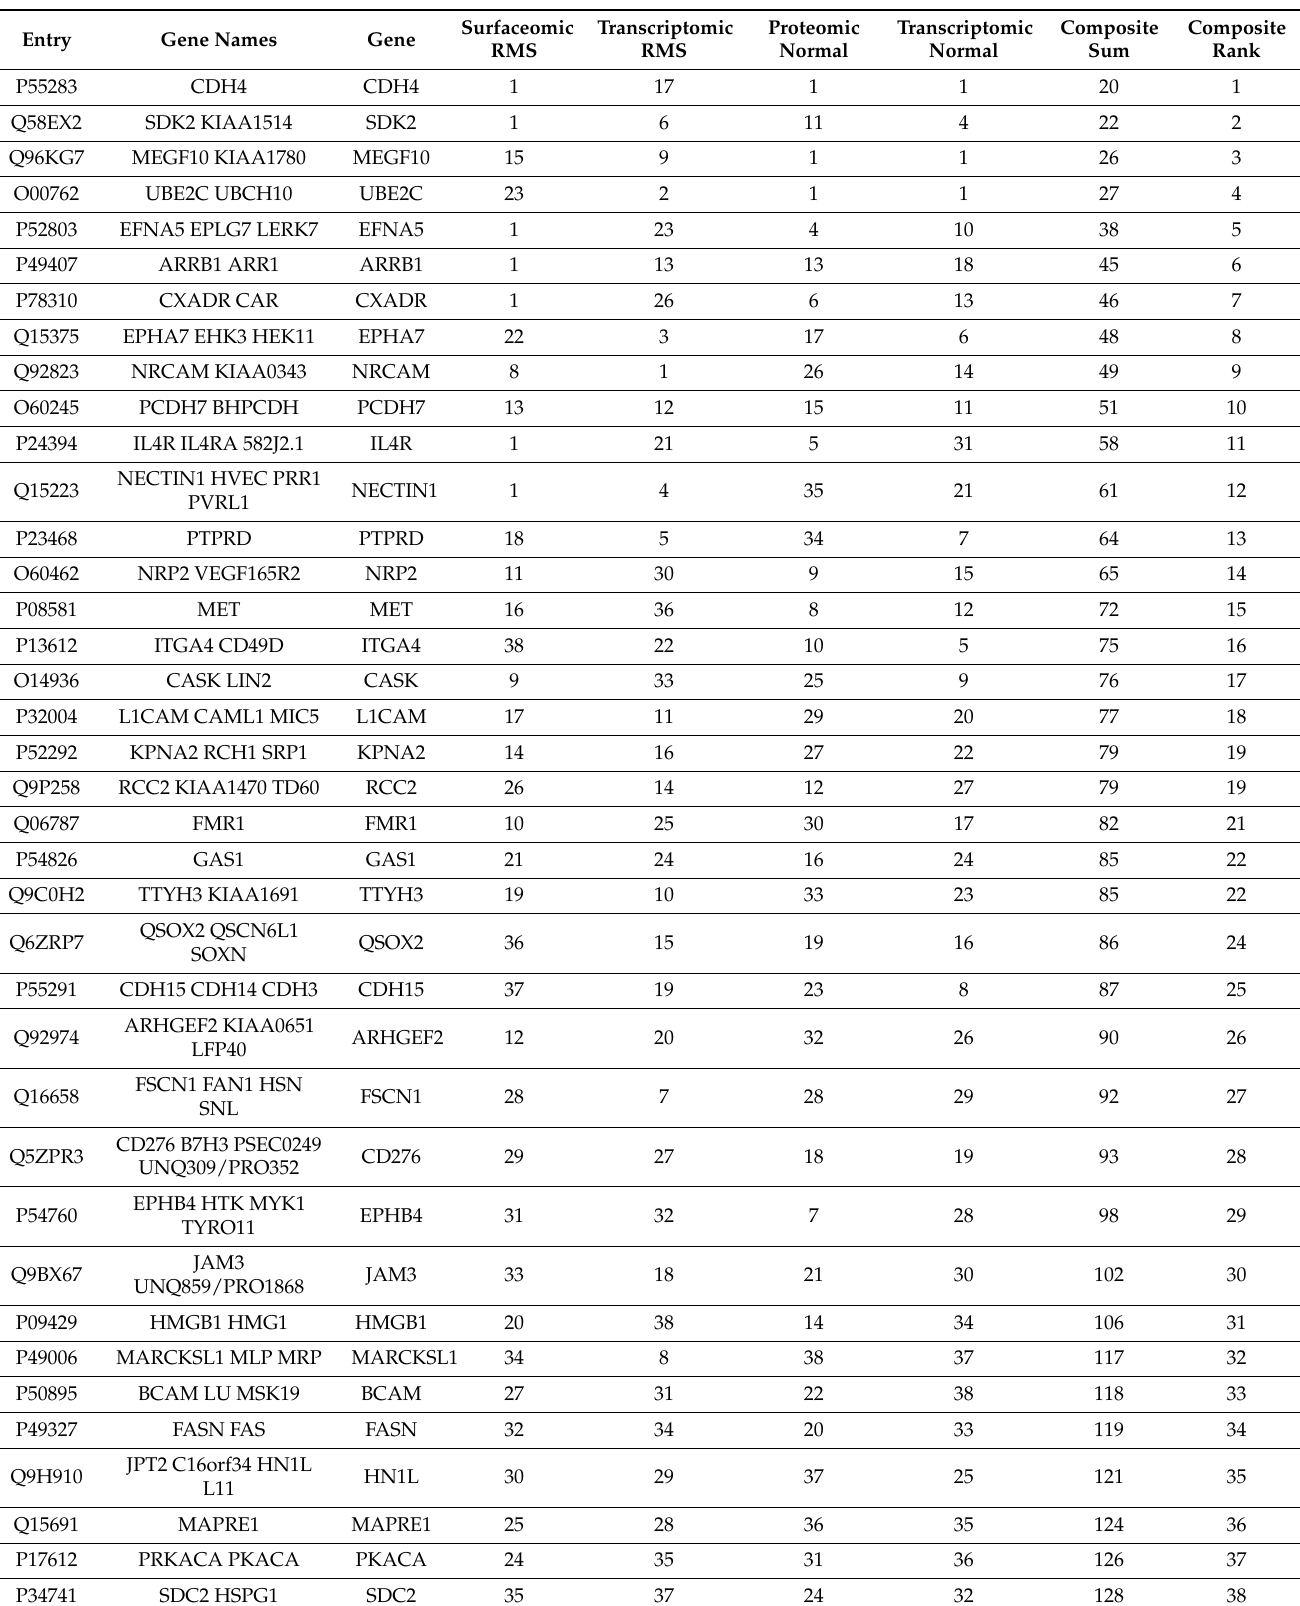
Table 3. Composite ranking of fusion-positive RMS-enriched cell-surface proteins based on combined transcriptomic and proteomic